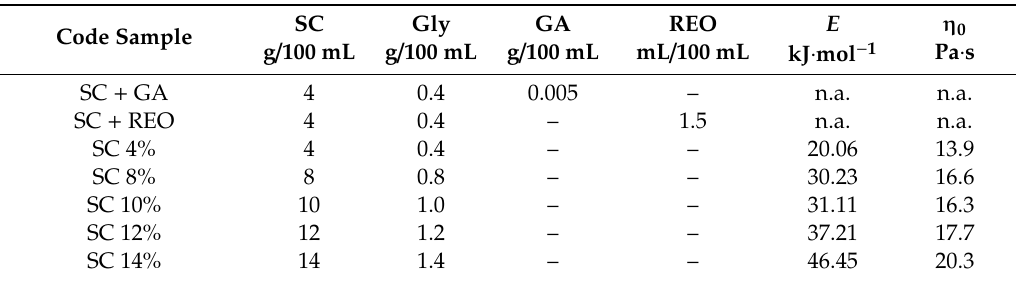
Table 1. Composition of coating / film (sodium caseinate (SC), glycerol (Gly), gallic acid (GA), rosemary essential oil (REO)) and activation energy ( E ), and the pre-exponential factor of Arrhenius-type equation ( η 0 ). n.a. = not available data SC Gly GA REO E η 0 Code Sample g / 100 mL g / 100 mL g / 100 mL mL / 100 mL kJ · mol − 1 Pa · s SC + GA 4 0.4 0.005 – n.a. n.a. SC + REO 4 0.4 – 1.5 n.a. n.a. SC 4% 4 0.4 – – 20.06 13.9 SC 8% 8 0.8 – – 30.23 16.6 SC 10% 10 1.0 – – 31.11 16.3 SC 12% 12 1.2 – – 37.21 17.7 SC 14% 14 1.4 – – 46.45